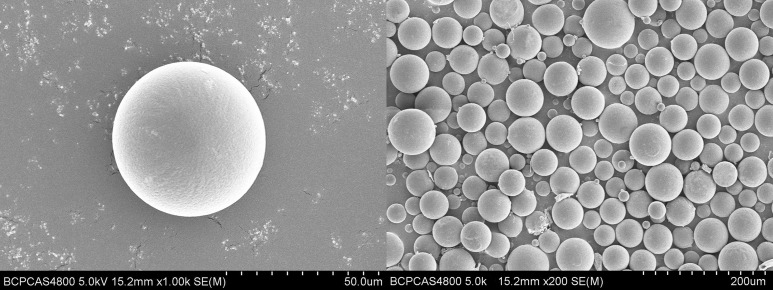
Scanning electron micrographs of nalmefene loaded PLGA microspheres.